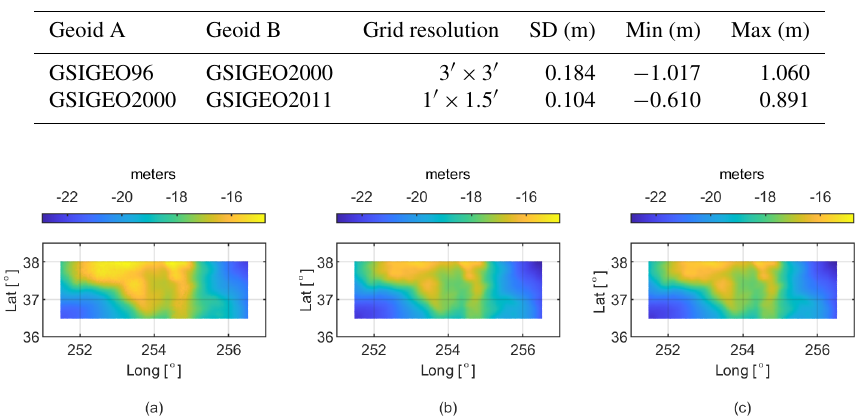
Figure 8. Local and global geoid models. The three panels show the geoid undulation over the Colorado (US) area with respect to the reference ellipsoid of (a) ColWLSC2020, (b) EIGEN-6C4, and (c) EGM2008.